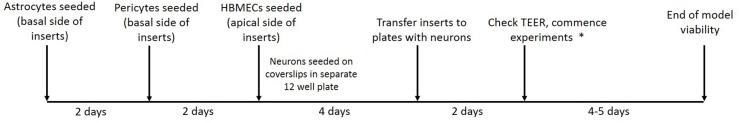
Timeline showing stages of model establishment. On day 1, inserts were coated and astrocyte seeded on the basolateral side of transwell inserts and on day 3 pericytes were seeded on the basolateral side of inserts to form a mixed culture. On day 6 HBMECs were seeded on the apical side of inserts and neurons were seeded on coated plastic coverslips in a separate 12 well plate. On day 10/11, inserts are carefully lifted out of their current plate and placed into the second 12 well plate containing the neurons seeded on coverslips. After 2 days, TEER measurements are taken to ensure adequate barrier formation. ∗In our lab OGD experiments were commenced at this point and were viable for 4–5 days.